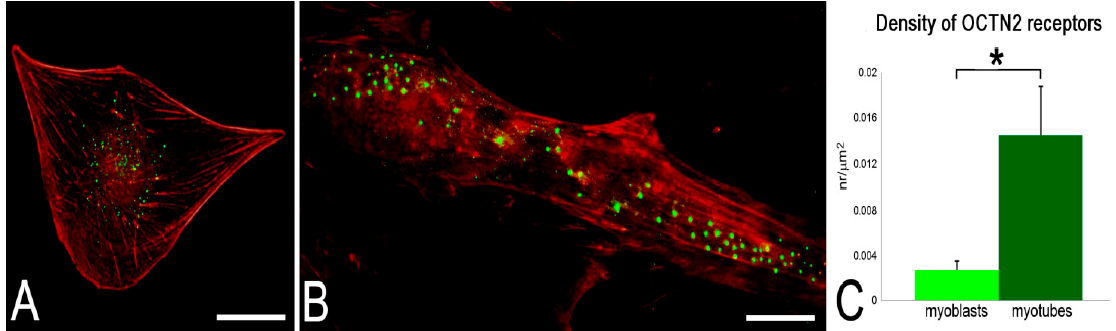
Figure 6. CFM micrographs of a myoblast ( A ) and a myotube ( B ), immunolabelled for OCTN2 (green); counterstaining with phalloidin (red). Bars, 20 µm. Note the higher density of receptors in the myotube ( C ); data are given as mean values ± SEM. * p < 0.001.